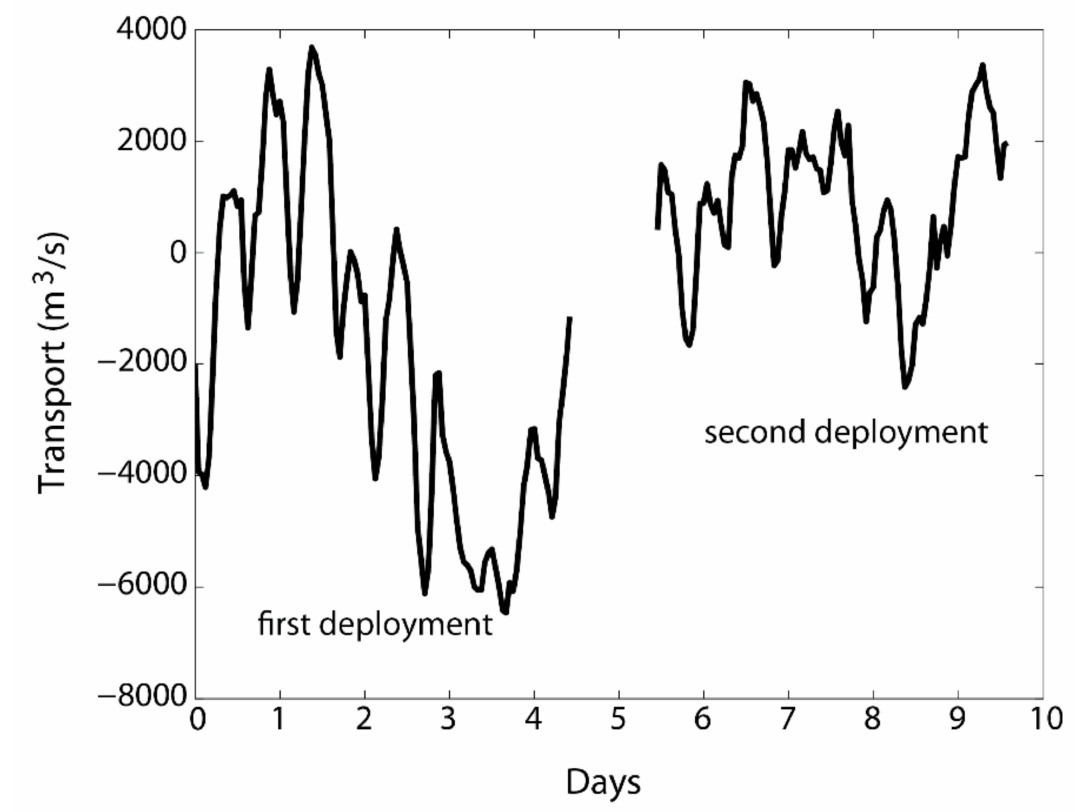
Figure 8. Transport computed for the first and second deployments. The horizontal axis is time in days from the beginning of the first